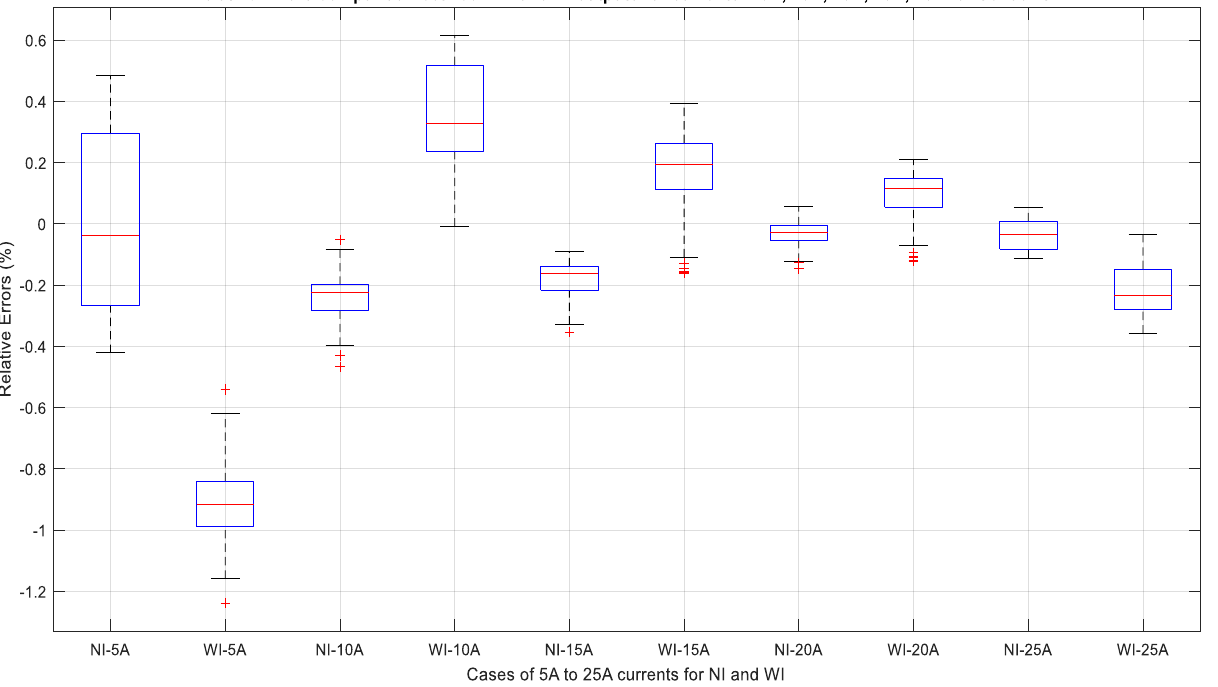
Figure 15. Relative errors in outputs of the sensors S7 to S12: WI and NI case.